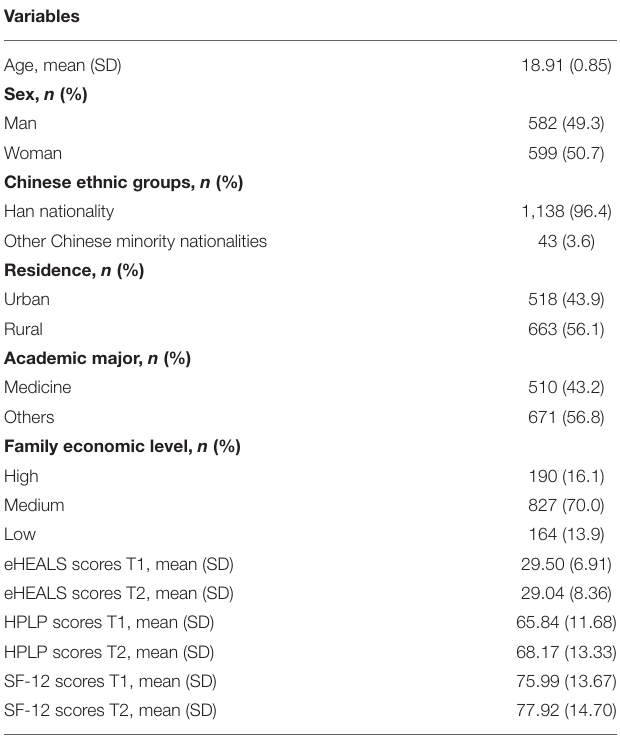
TABLE 1 | Descriptive statistic for all variables ( N =